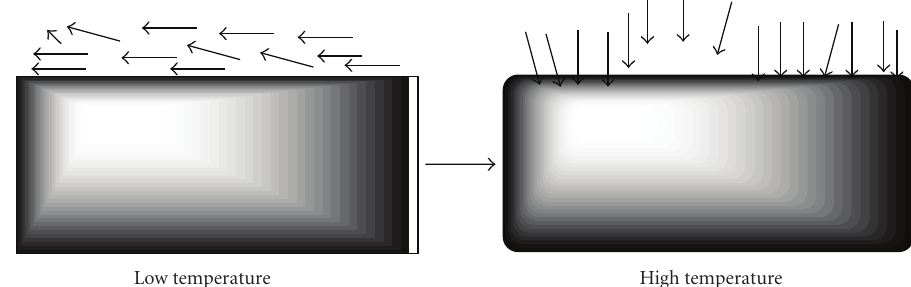
Low temperature High temperature Scheme 2: Arrows show the orientation of inhibitor structure on the surface of